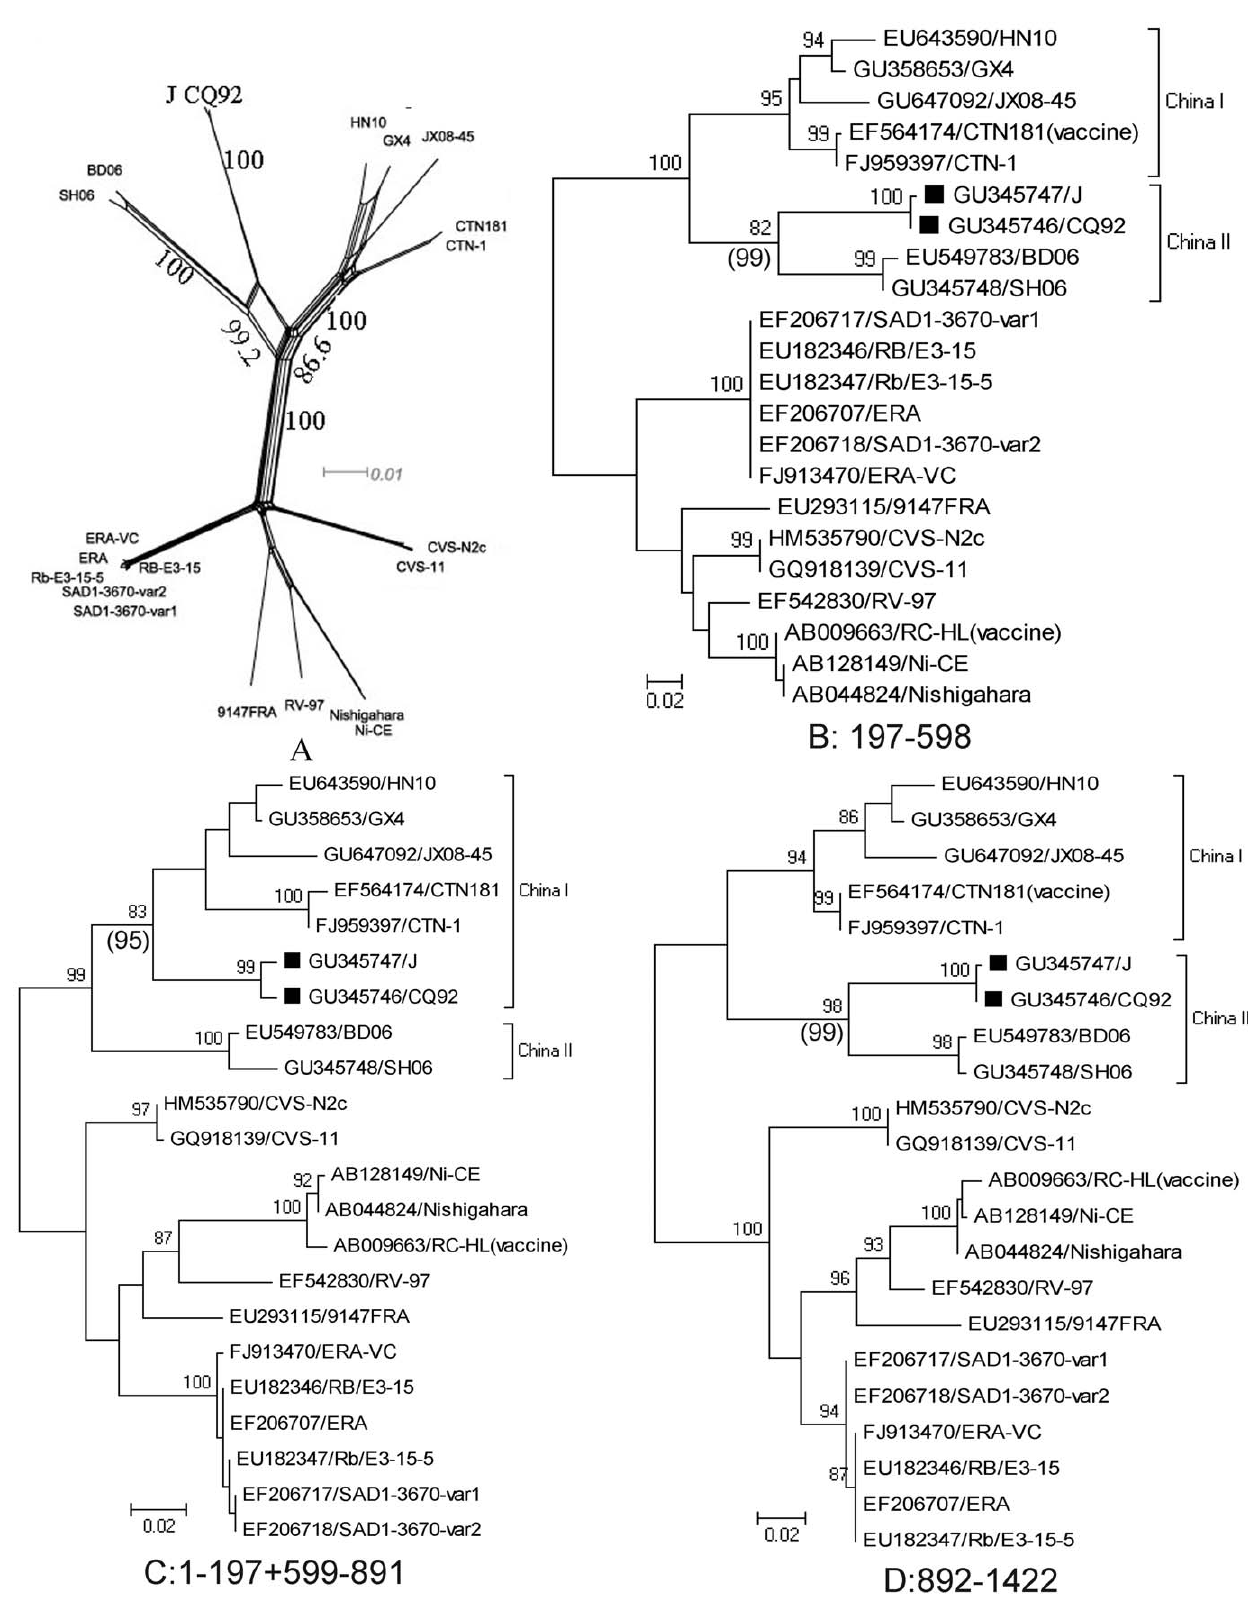
Figure 4. Analysis of the origin of the CQ92 lineage in different regions of the N gene delimited by the putative breakpoints. (A) A split tree inferred from the complete N gene sequence showing the evolutionary relationship. A networked pattern of mosaic lineage was found to be related to lineages GX4 and SH06. The Neighbor-Net tree was constructed by employing the SplitsTree4 program. (B) Phylogenetic relationships